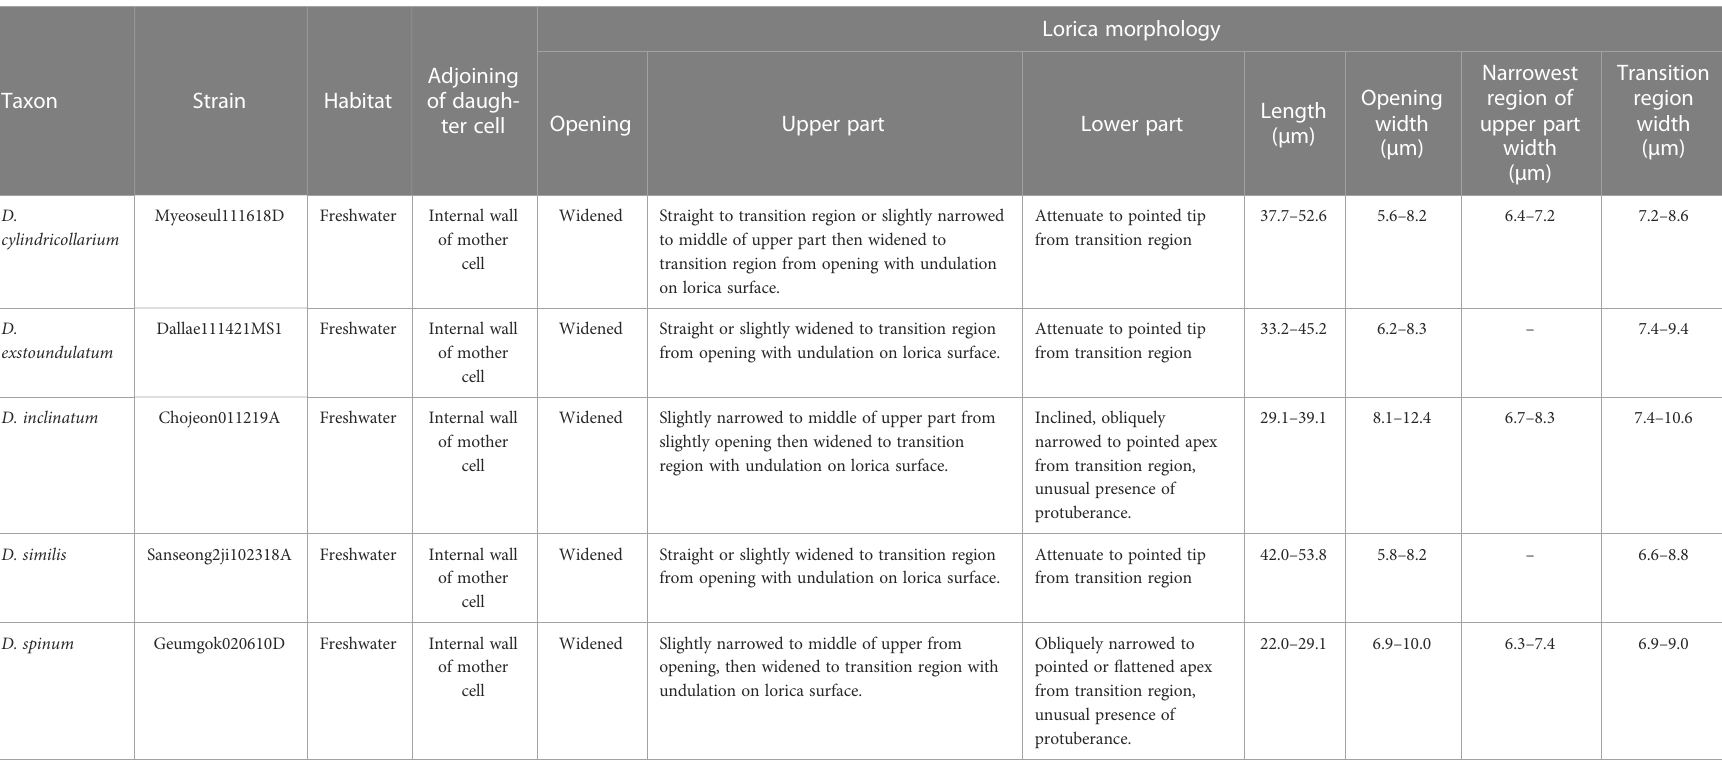
TABLE 1 Summary of the lorica morphological characteristics of new Dinobryon